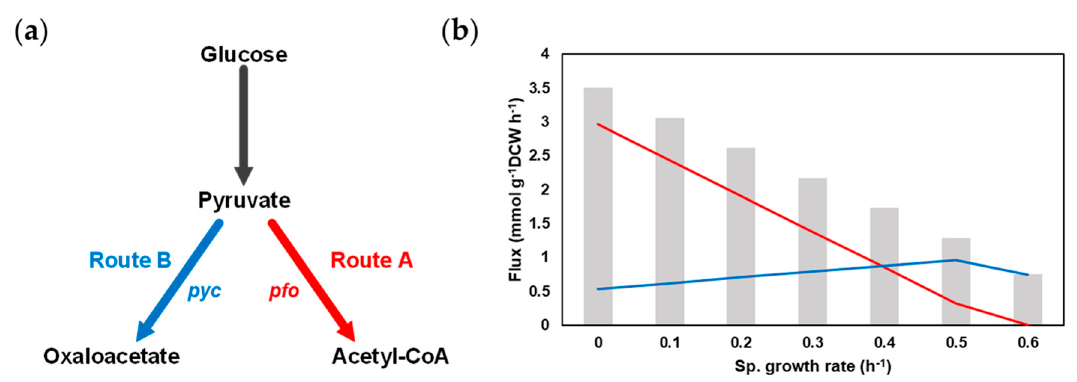
Figure 3. Flux ratio analysis for hexanoic acid synthetic pathways in M. elsdenii . ( a ) Manipulation of flux ratio with pfo and pyc reactions. ( b ) Flux distributions towards Routes A (Red) and B (Blue) at di ff erent specific cell growth